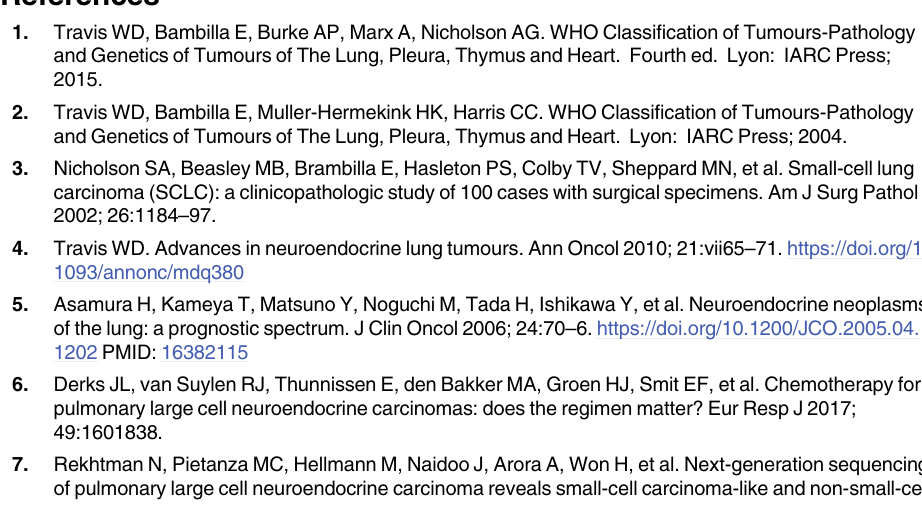
S3 Table. The PPI network information performed for pathway enrichment. S4 Table. Top 20 genes in network ranked by degree